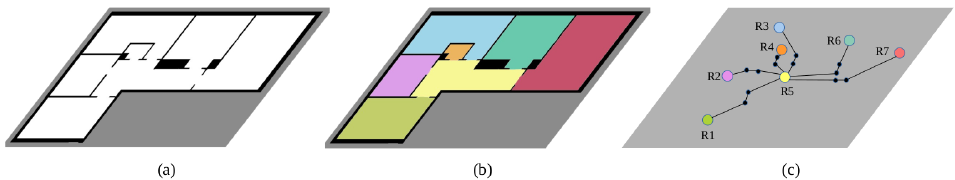
Figure 4. Topological map extraction: ( a ) initial occupancy grid map, ( b ) segmented map, where each color corresponds to a different location, ( c ) topological map, where colored nodes correspond to rooms and black dots indicate door